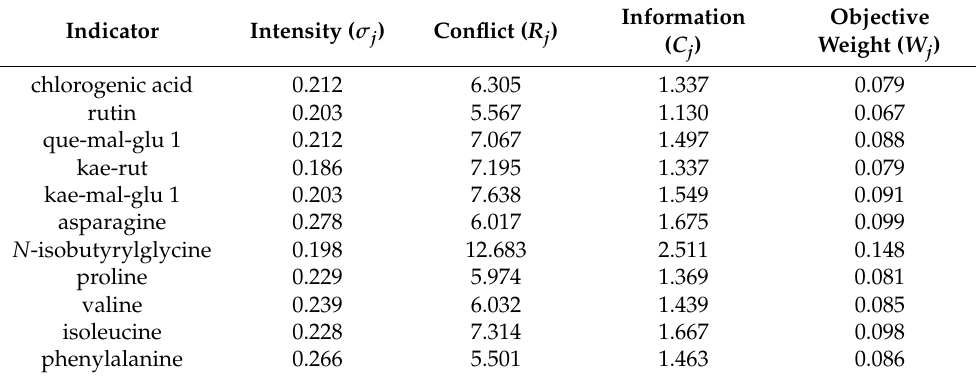
Table 2. Comparison of intensity, conflict, information, and objective weight of each indicator.